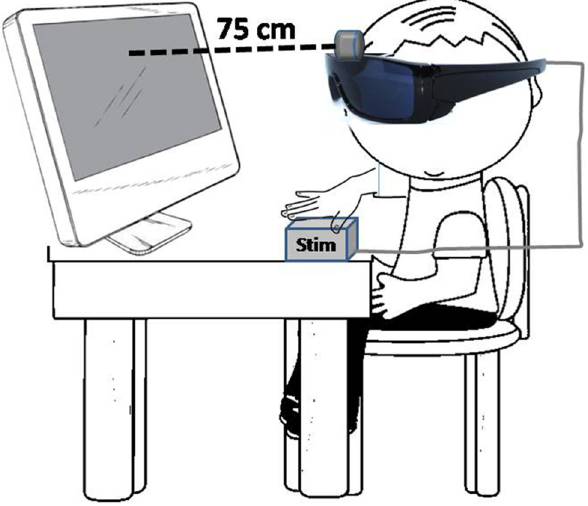
Fig 1. Schematic representation of the stimulus presentation set up. Stimuli are flashed in the LCD screen, read out by a camera mounted on the dark glasses, transformed into digital input and fed as tactile stimulation to the hand of the